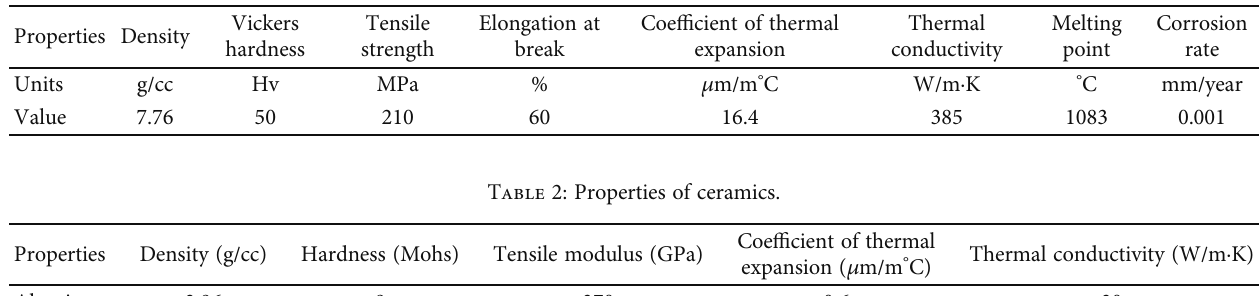
Table 1: Properties of pure copper.